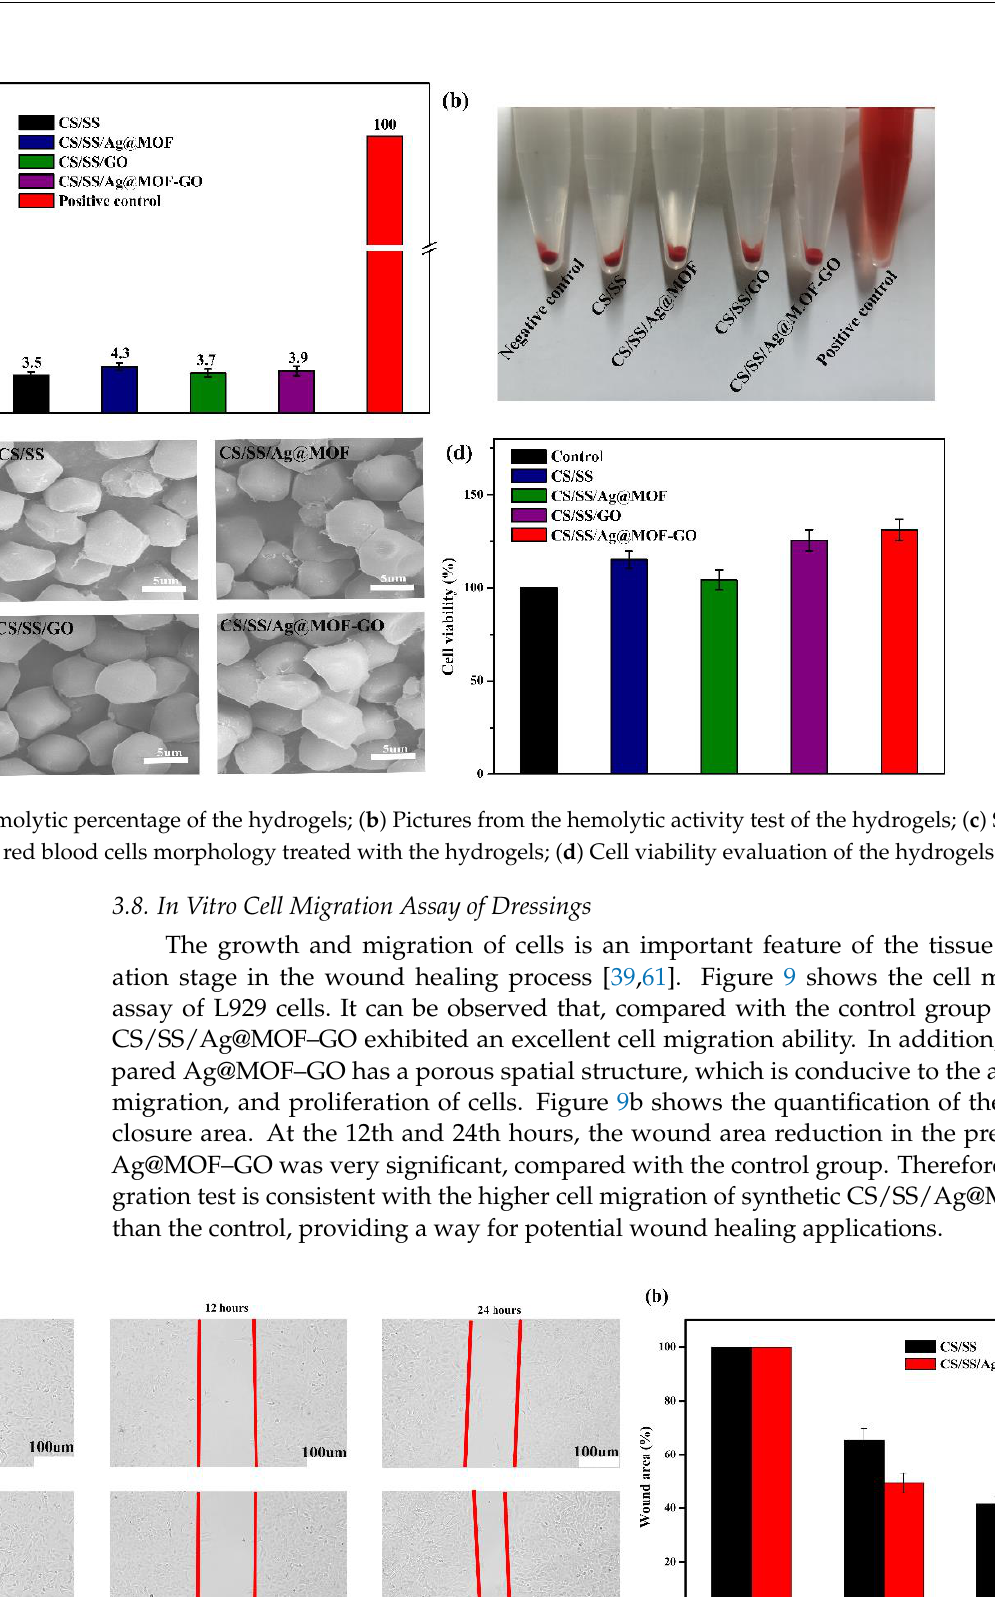
16 of 22 Figure 7. ( a ) Cumulative skin permeation profiles of Ag. ( b ) Antibacterial rates of the extracts of Ti–Ag samples. 3.7. Biocompatibility of Dressings Good biocompatibility is an important factor in wound dressings [54]. A hemolysis test was examined for an assessment of the blood compatibility of the sample. Figure 6b shows the color difference between the four sample groups, the positive control group, and the negative control group. Light yellow was observed in all four sample groups, similar to the negative control group, while bright red was observed in the positive control